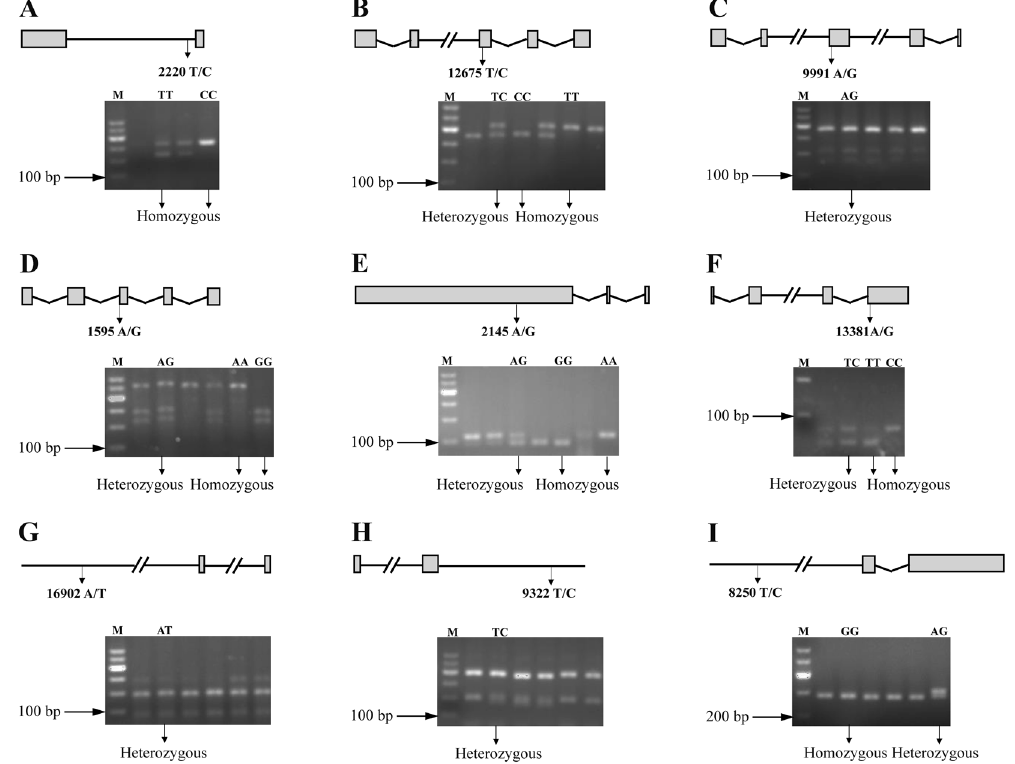
Figure 6. Gene structure schematics and polymorphism site confirmation. 22 SNPs associated with resistance/ susceptibility to GCRV in individuals were selected for SNP verification, and 9 SNPs were confirmed. ( A–I ) show the 9 proved SNPs, including Hnrpa , Yes , Zfyve26 , Gsto , C7N1 , Napi-llb2 , Mef2d , Hiat and Chsg genes, respectively. Double slash, grey box and polygonal line represent ellipsis, exons and introns, respectively. The polymorphism sites are marked by vertical arrows in gene organization plots and the genotypes of SNPs are demonstrated on the corresponding electropherogram. M, Maker